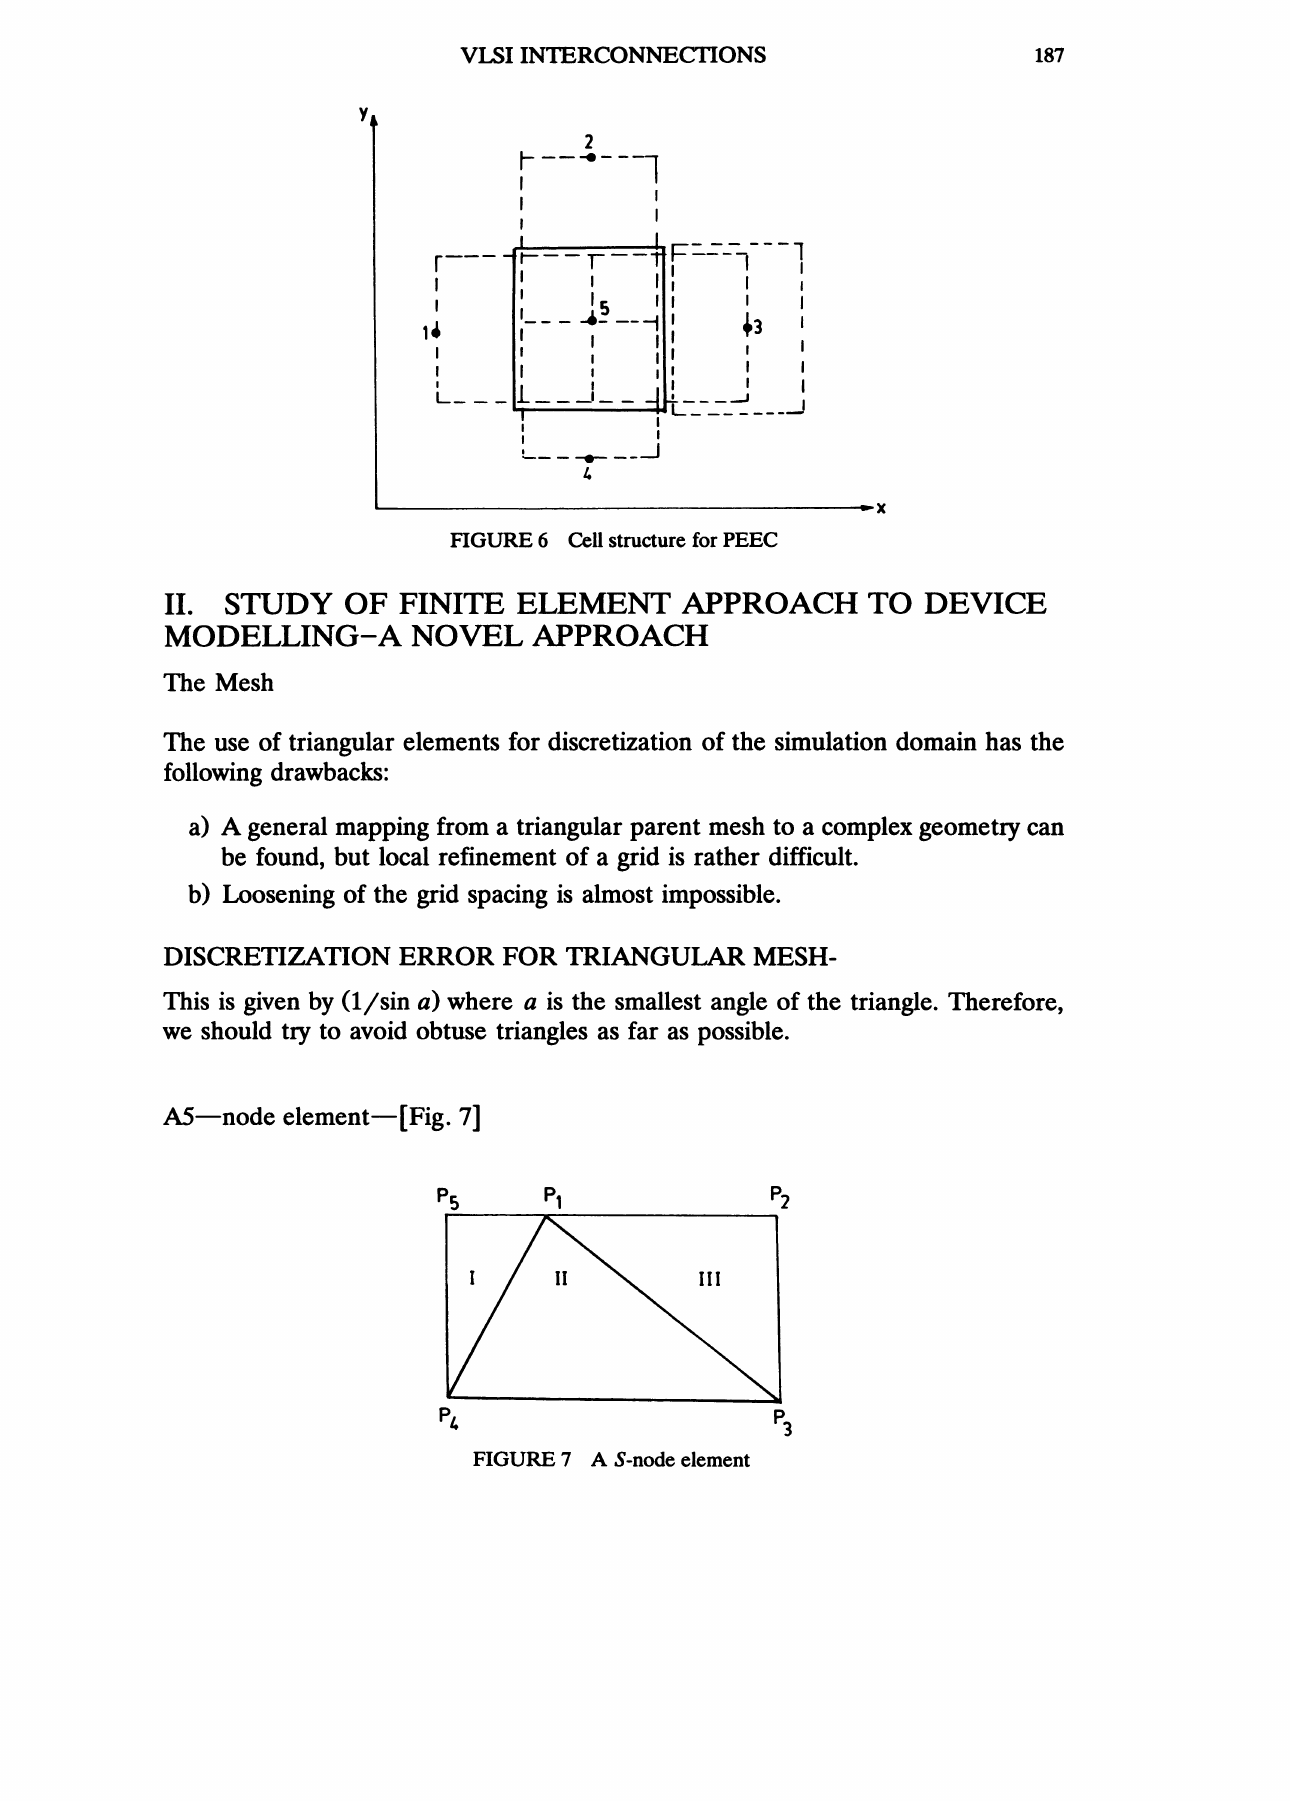
FIGURE 6 Cell structure for PEEC